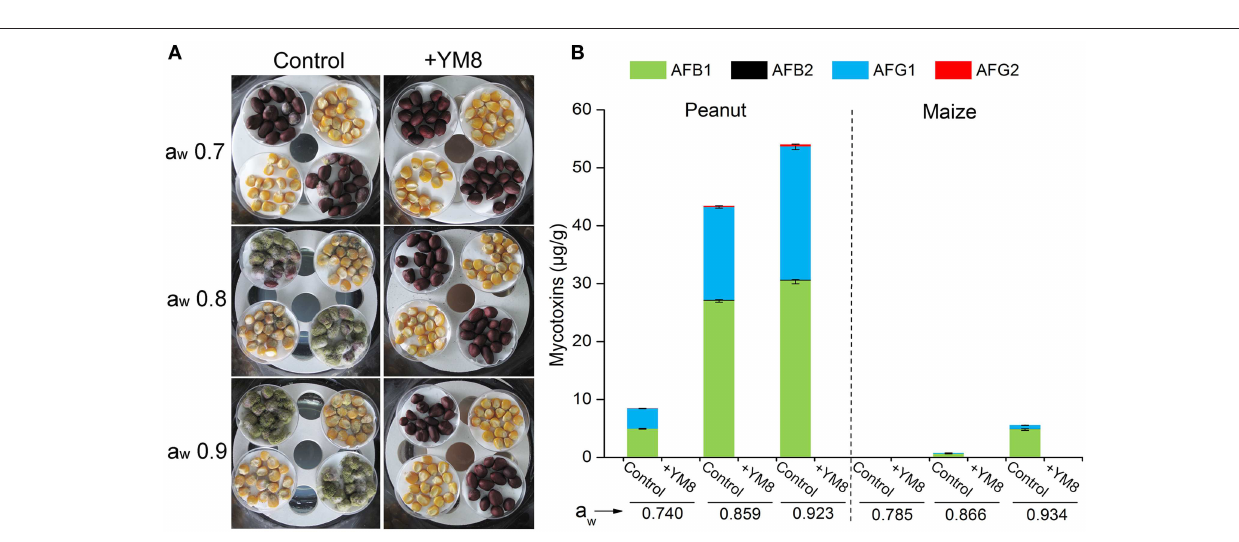
FIGURE 5 | Efficacy of bacterial strain YM8 for bio-control against Aspergillus flavus and aflatoxins in peanuts and maize. (A) Phenotypes of peanuts and maize infected with Aspergillus flavus in the presence or absence (control) of strain YM8 at 28 ◦ C for 7 days. (B) Aflatoxin content in peanuts and maize samples from (A) . Data represent the means ± SE from three